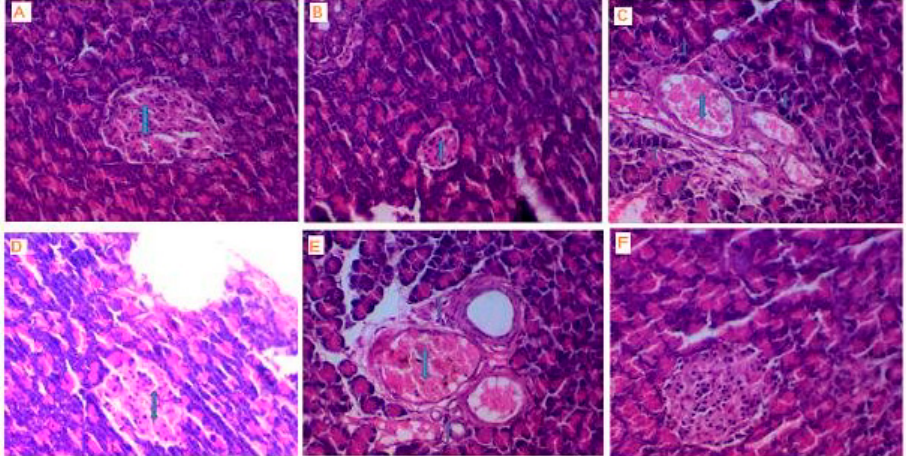
Figure 7. (A) Normal control of the pancreas. Photomicrograph of normal pancreatic tissue showing normal-sized islet of Langerhans ( ↕ ) surrounded by normal pancreatic acini. Hematoxylin and eosin (H&E) stain ×400). ( B ) Positive diabetes mellitus (DM) control of the pancreas. Photomicrograph of pancreatic tissue of diabetic rat showing atrophy of the islet of Langerhans ( ↕ ) surrounded by normal pancreatic acini. (H&E stain ×400). ( C ) Positive DM control of the pancreas. Photomicrograph of pancreatic tissue of diabetic rat showing dilated congested vascular spaces ( ↕ ) surrounded by aggregates of inflammatory cells ( ↑ ) and pancreatic acini. (H&E stain ×400). ( D ) Pancreas of the treated group with VOSO 4 . Photomicrograph of pancreatic tissue of diabetic rat treated with VOSO 4 showing slight increase in the islet of Langerhans ( ↕ ). (H&E stain ×400). ( E ) Pancreas of the treated group with VOSO 4 . Photomicrograph of pancreatic tissue of diabetic rat treated with VOSO 4 showing still dilated congested vascular space ( ↕ ) surrounded by few aggregates of inflammatory cells ( ↑ ). (H&E stain ×400). ( F ) Pancreas of the treated group with [(FA)(VO)(AA 1 )(NH 4 )] complex. Photomicrograph of pancreatic tissue of diabetic rat treated with NH 4 [(VO)(FA)(AA 1 )] complex, showing a good response with return of islet of Langerhans ( ↕ ) to its normal size. (H&E stain ×400).